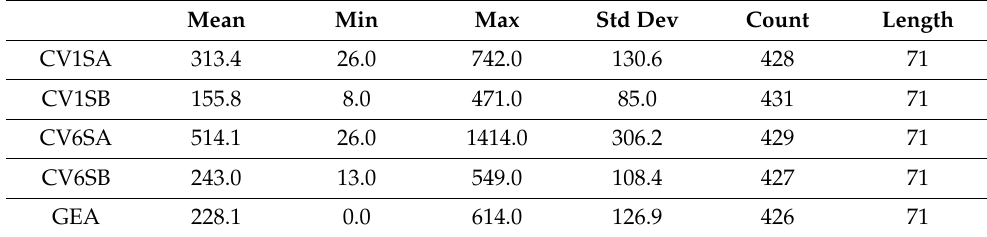
Figure 7. ( a ) Actual recording intervals of the five instruments. ( b ) Radon concentration data was recorded at the five stations considered in Experiment 2. CV6SA-B located on the VI floor of building #1, CV1SA-B on the I floor of the same building, and GEA on the II floor of building #2, according to the sketch on the right. Table 1. Descriptive statistics of the time series of radon concentration recorded in the five rooms of Experiment 2. The values refer to the time interval March–May 2021, when all the radon devices were operating simultaneously. Columns I–III show the mean, minimum and maximum value of radon concentration (Bq/m 3 ) for each time series; column IV the standard deviation, columns V–VI the number of collected data, and the length (days) of the time